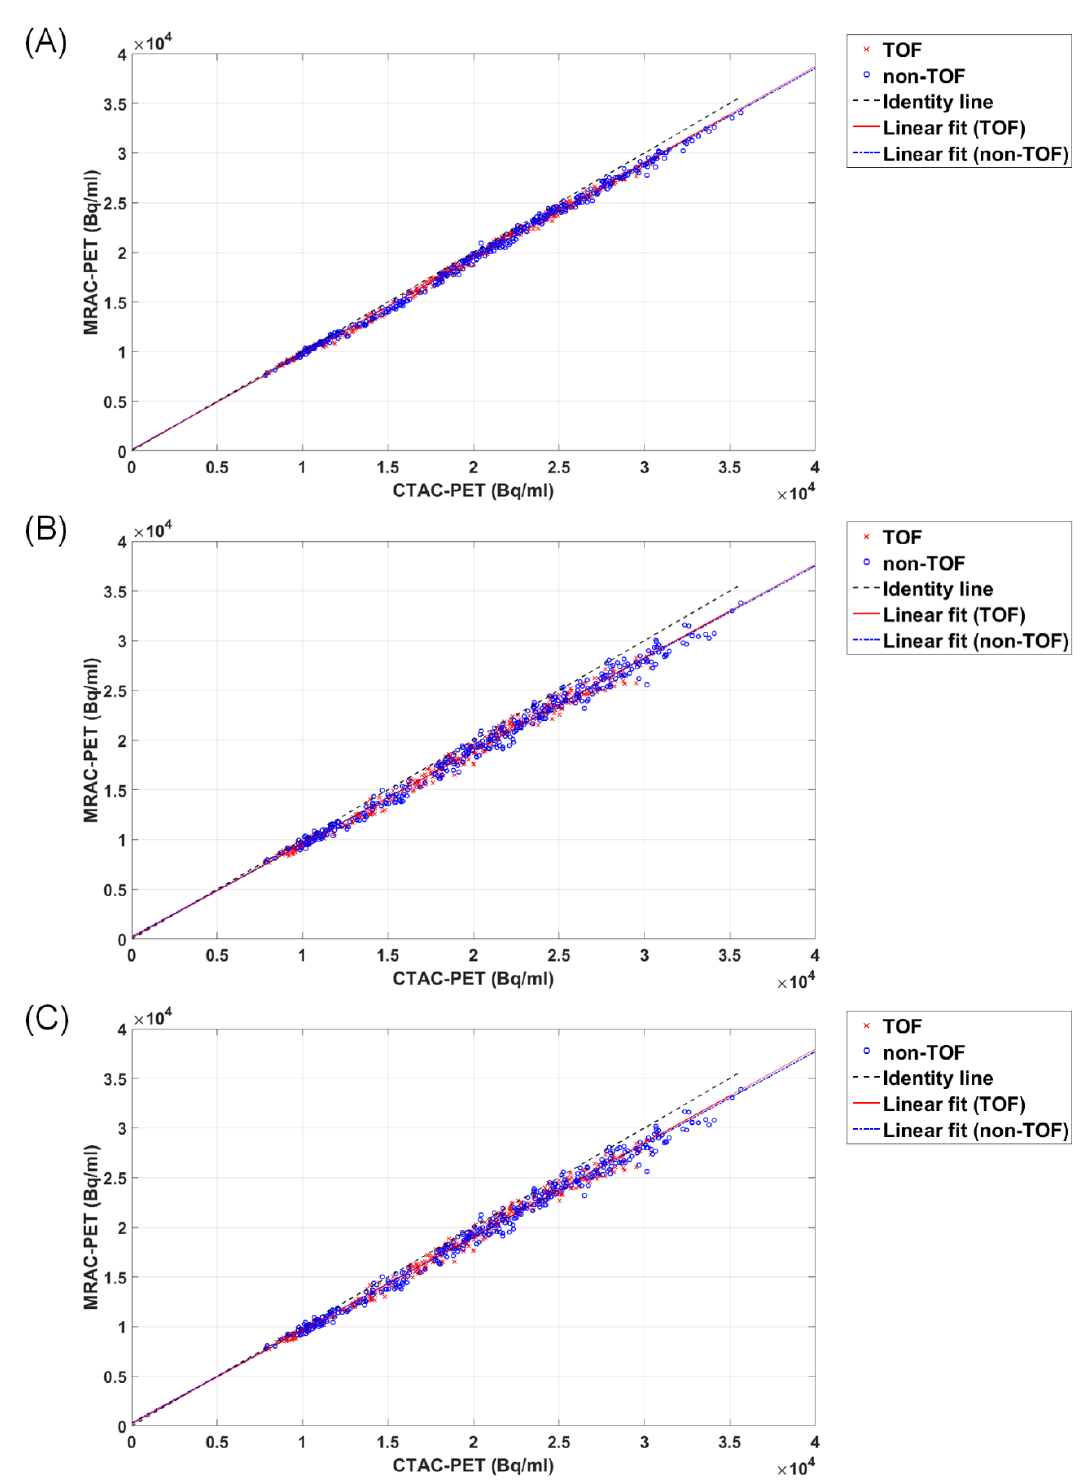
Figure 3. Regression plots of non-TOF (marked as blue ‘o’ symbol) and TOF (marked as red ‘×’ symbol) reconstructed activity values with different MRAC methods versus CTAC reconstructed